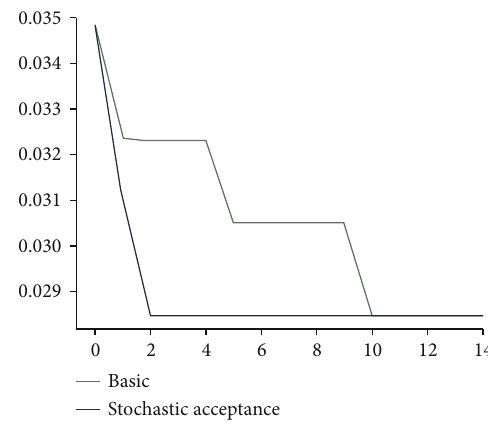
Figure 2: The shrinkage speed by varying the number of